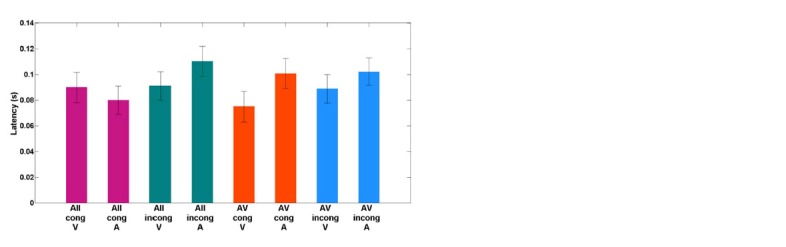
DOI:
http://dx.doi.org/10.7554/eLife.14521.016